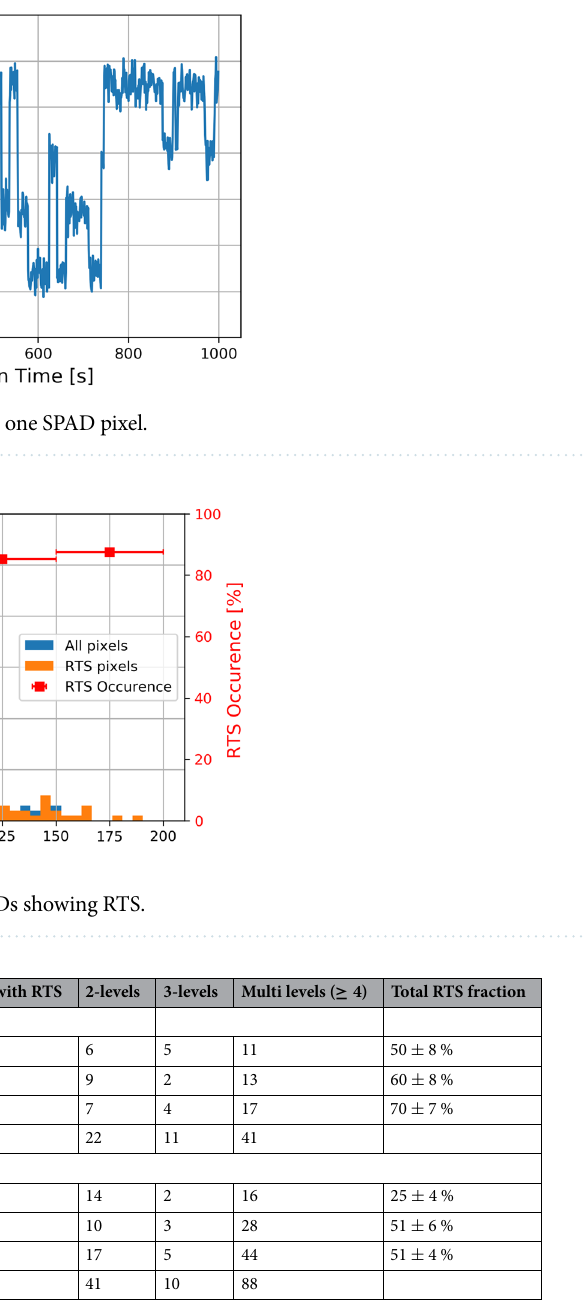
Table 2. RTS occurrence in irradiated SPADs with DDD=115